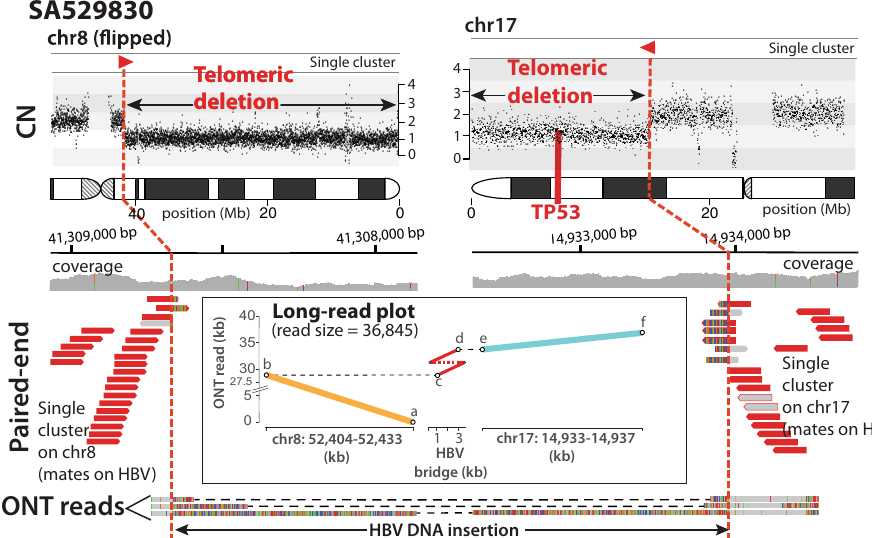
Fig. 6 HBV-mediated translocations may lead to loss of tumour suppressor gene TP53 . In HCC SA529830, a cryptic interchromosomal rearrangement between chromosomes 17 and 8 is bridged by a 4829 bp HBV insertion associated with a 14.9 Mb telomeric deletion on chromosome 17 that removes one copy of the tumour suppressor gene TP53 , and a second 43 Mb telomeric deletion on chromosome 8. Note that the CN plot on chromosome 8 is fl ipped for illustrative purposes. Single paired-end clusters (short-reads in red) on chromosomes 17 and 8 demarcate the boundaries of both deletions and support the insertion of HBV DNA. One ONT read of 36,845 bp evidences the extent of the rearrangement, whose alignment onto the reference genome – chromosomes 8 and 17 – and to a consensus HBV sequence is shown in the long-read plot. ONT reads were cut (discontinued) for illustrative purposes. The con fi guration of the rearrangement predicts the formation of a dicentric chromosome (Fig. 3b). The long-reads used to construct the long-read plots are annotated in Supplementary Table